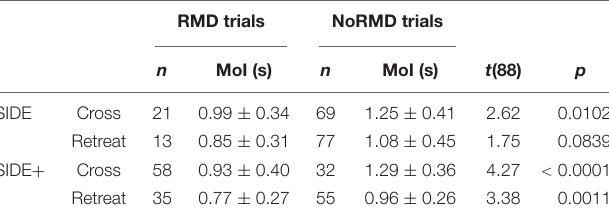
TABLE 2 | Moments of initiation (MoI, M ± SD ) and statistical comparison t -test results of first steering action for trials with a reversal in movement direction (RMD trials) and trials without a reversal in movement direction (NoRMD trials), with number of observations n , under the Cross and Retreat direction conditions of the SIDE and SIDE + eccentricity